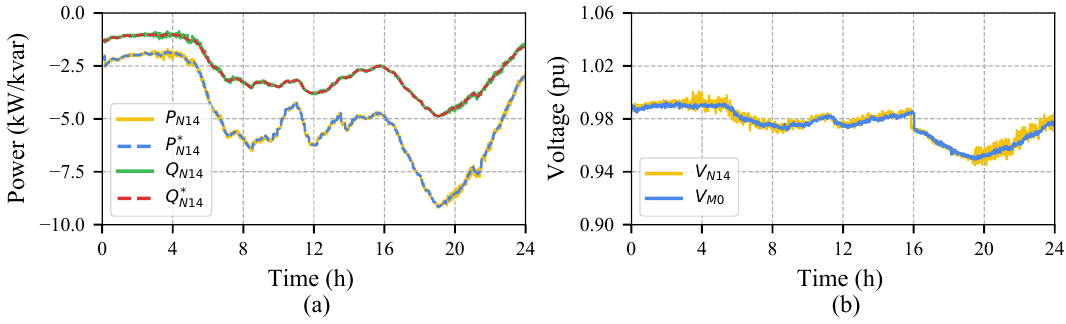
Figure 10. PSHIL-1: N14 industrial load and integration of the LV real-time simulated network within the MV scaled-down physical system. ( a ) 24-h evolution of active and reactive power injected by the OLE connected to bus N14. ( b ) 24-h evolution of voltages in bus N14 (physical network) and M0 (real-time simulated network).